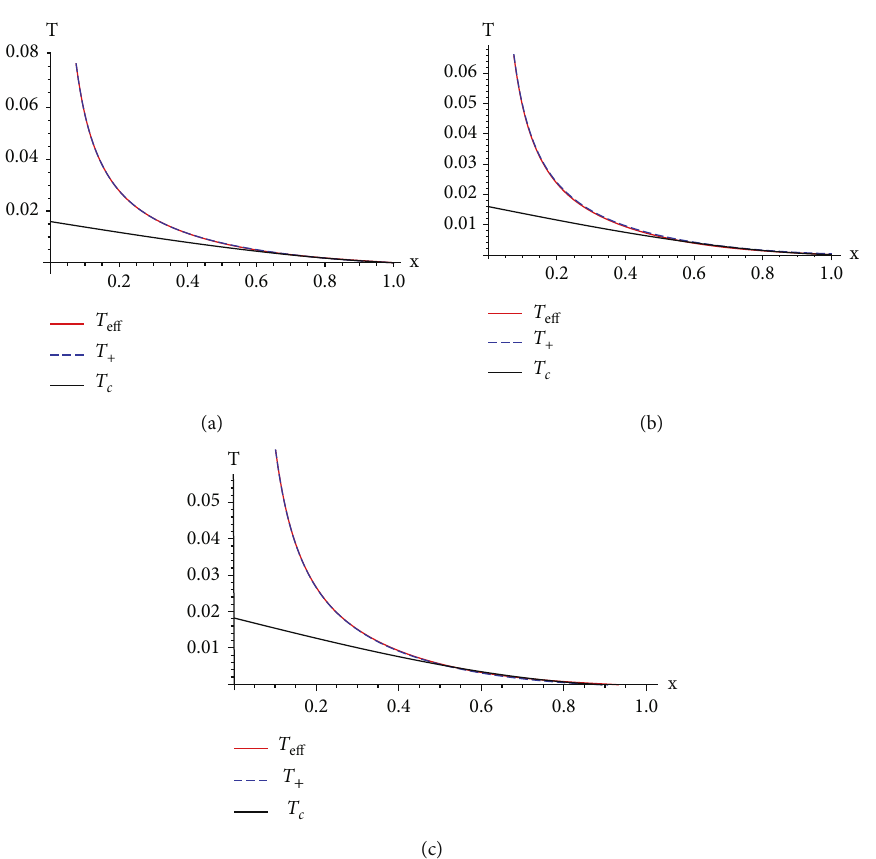
− x curves with l 2 = 100 , and (a) for ϕ 2 +, c , ef f